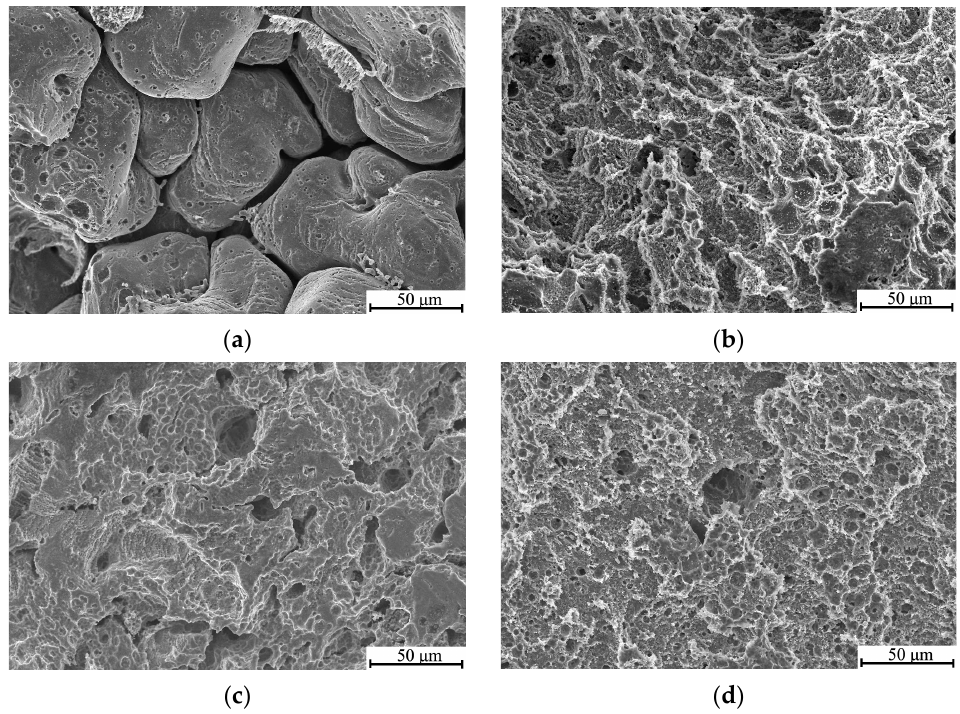
Figure 8. SEM images (in secondary electrons) of the surface of the Mg-2Sr alloy after an immersion time of 30 days: in the initial ( a ); ECAP ( b ); cSPD ( c ) and cSPD-AA ( d ) states.